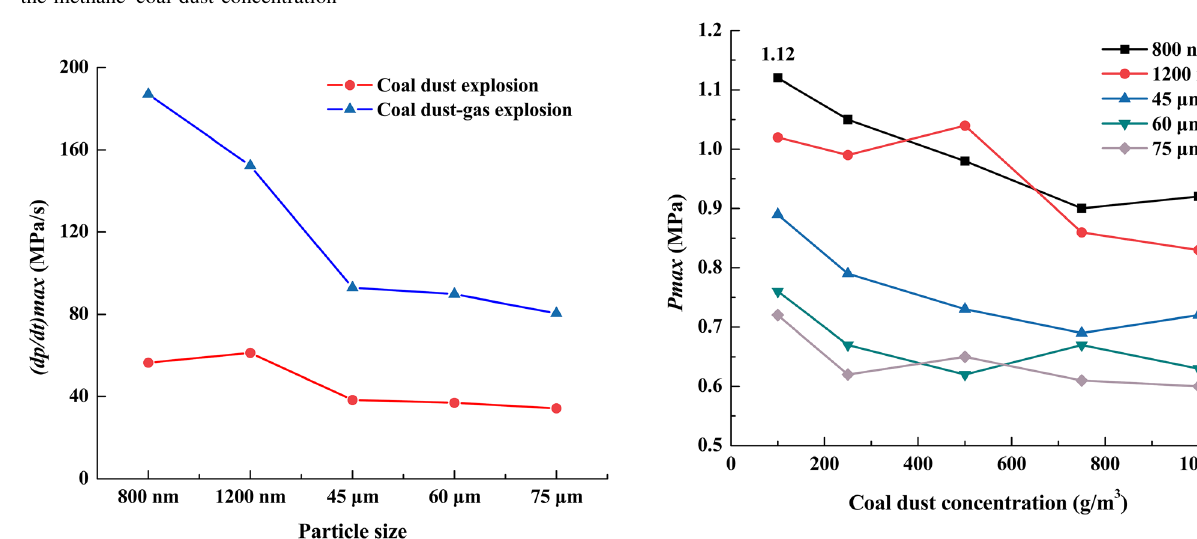
Fig. 10 Relationship between the maximum rate of pressure rise and the methane–coal dust concentration